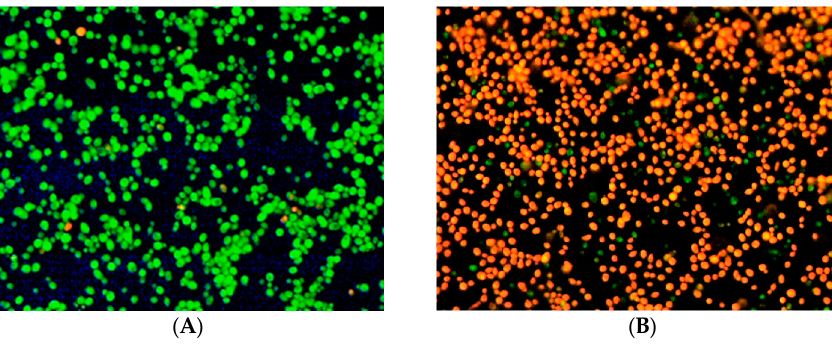
Figure 3. Visualization of C. albicans culture under fluorescence microscope: ( A ) C. albicans , incubated without compound; and ( B ) C. albicans , incubated with compound 5w